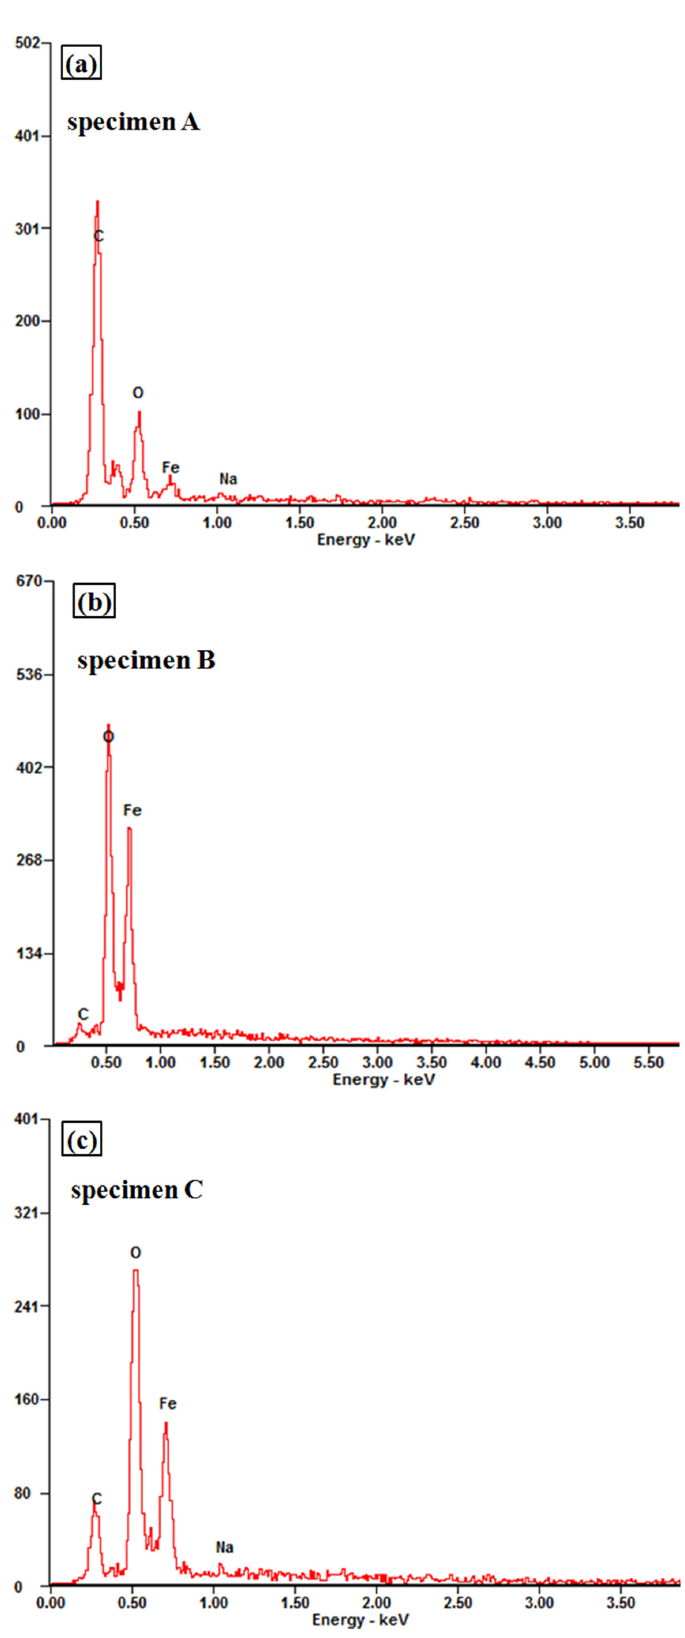
Figure 8. EDX analysis of the fracture inclusions on cross sections of high-strength wires: ( a ) A, ( b ) B and ( c ) C.